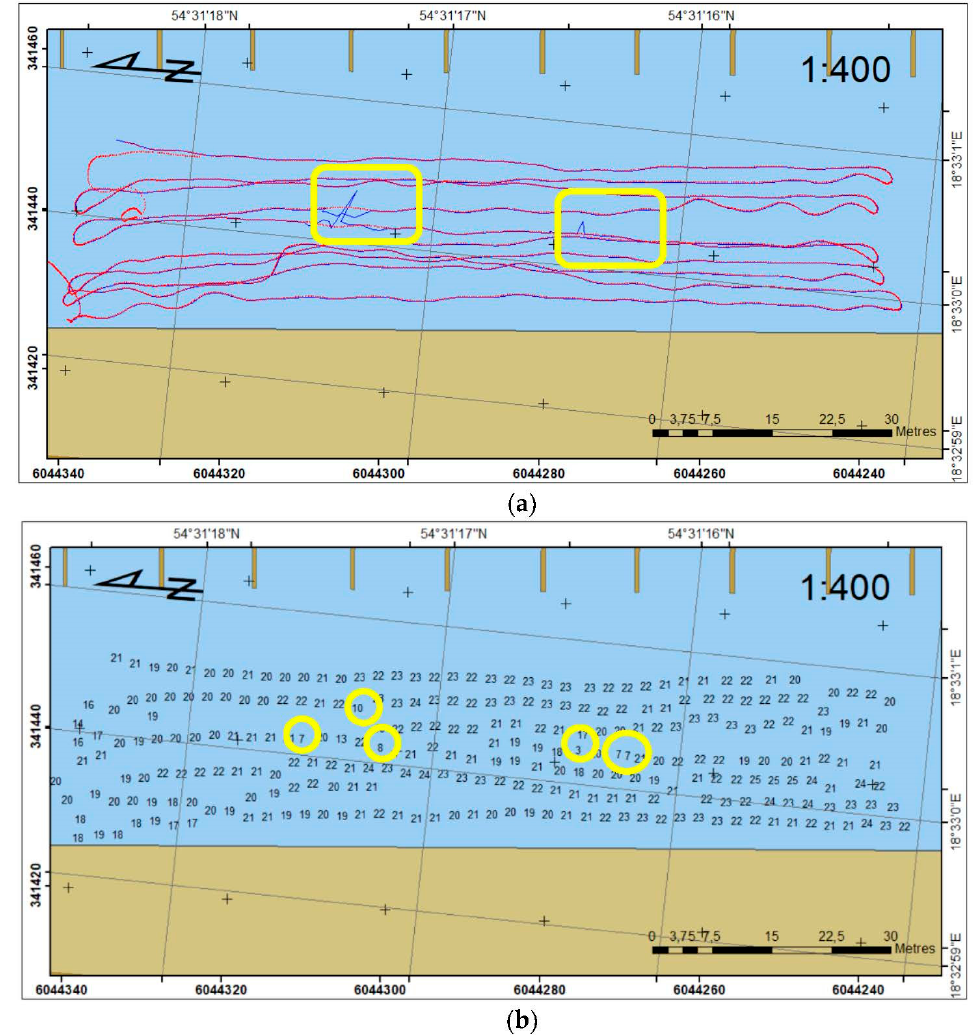
Figure 7. USVtrajectory( a ),totalnumberofusedsatellites( b Figure 7. USV trajectory ( a ), total number of used satellites ( b ) for USV positioning (GPS + GLONASS + Beidou).